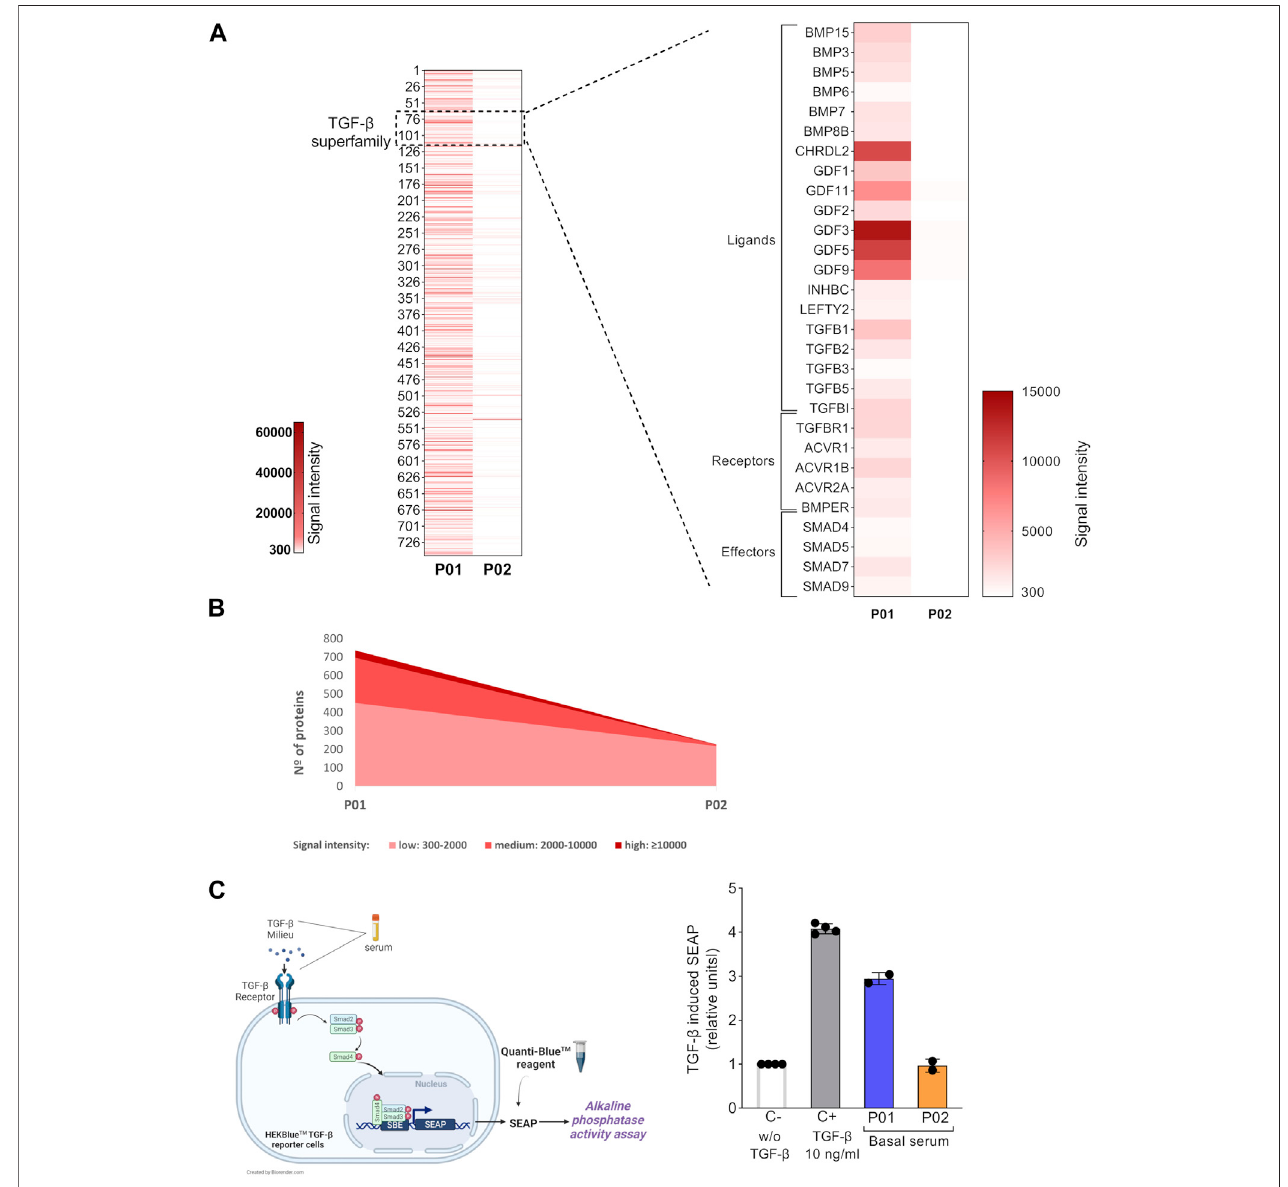
FIGURE 2 | Basal circulating TGF- β superfamily members ’ expression and bioactivity in OI patients. (A) Left heatmap shows the fl uorescent signal intensities for target proteins expressed in P01 and P02 basal sera samples. Only the spots with a fl uorescent intensity cutoff ≥ 300 above the background were considered. Right heatmap magni fi ed shows the fl uorescent intensities of the TGF- β superfamily members present in basal P01 and P02 sera are shown (right heatmap). (B) Graph showing the total number of expressed proteins in P01 and P02 basal sera, grouped according to their fl uorescent signal intensity: low (300-2,000), medium (2,000-10,000) and high ( > 10,000). (C) Left, schematic representation of the HEK-Blue-TGF- β TM reporter cell line assay. Right, Scatter plot with bars showing TGF- β -induced SEAP in HEK-Blue-TGF- β TM cells. The TGF- β induced SEAP from patients ’ sera samples is shown normalized versus that shown by the negative control (C-; w/o TGF- β ). C+ stands for the positive control, cells stimulated with TGF- β (10 ng/ml). The experiments were performed in octuplicates for each condition andrepeatedtwoindependenttimes.Dataaremean ±standard deviation obtained from thetwoindependentexperiments. Each dotrepresentsan independent